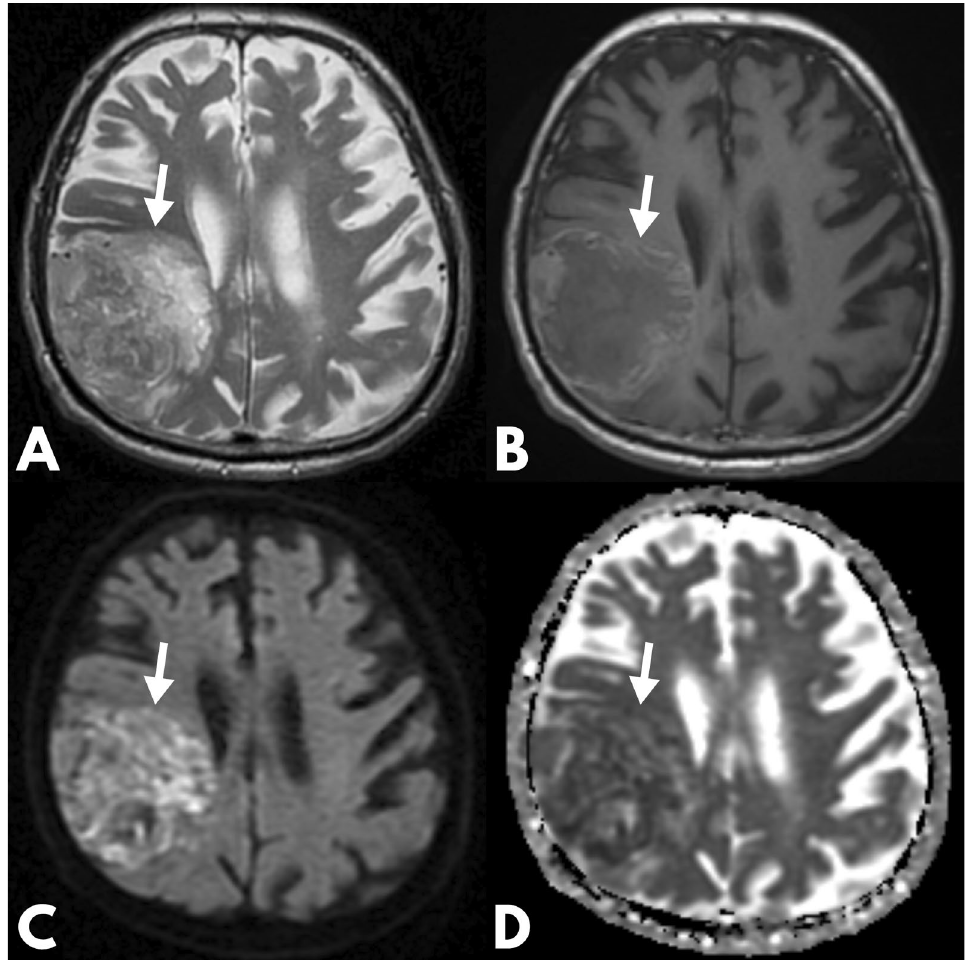
Fig. 1 A: In the axial T2W sequence of a glial tumour patient who was determined to be IDH-mutant histopathologically, there is a mass lesion in the right cerebral hemisphere with heterogeneous signal characteristics. B: Peripheral, heterogeneous, irregular contrast enhancement is distinguished on post-contrast T1W images. C and D: DWI and ADC sequences show diffusion